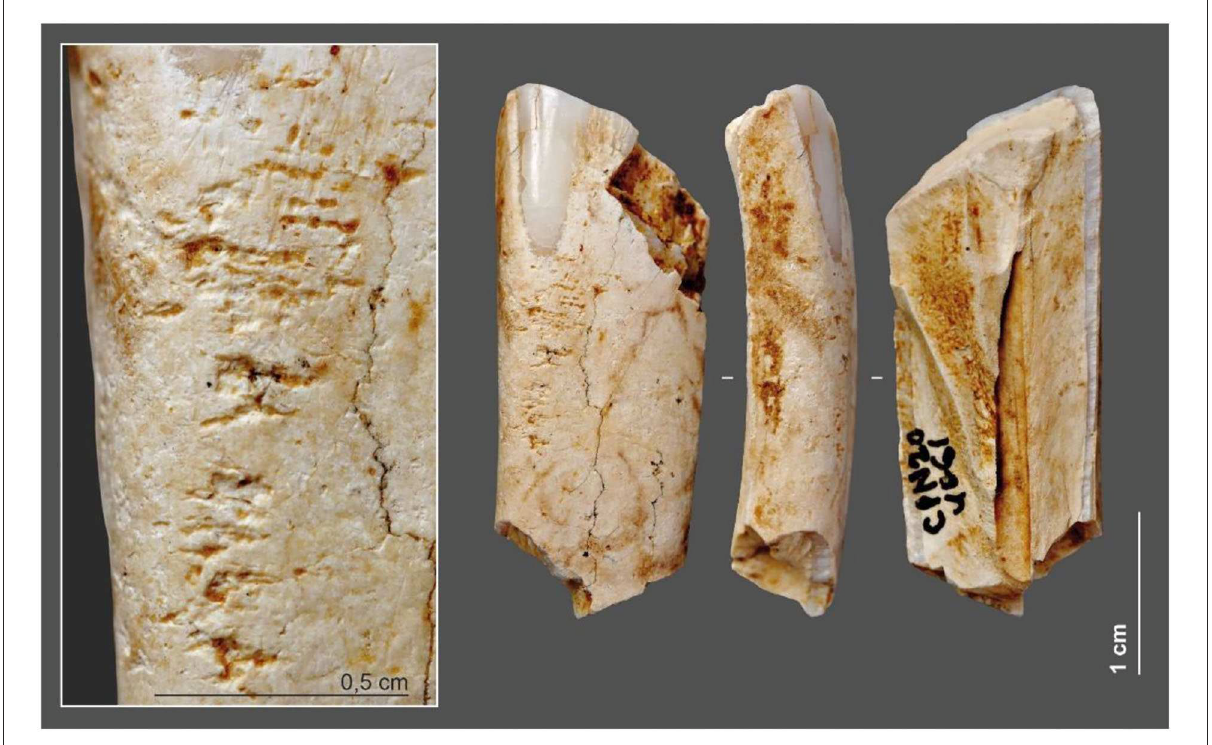
FIGURE8 Piece #4061, decapage 6. Upper horse incisor used as retoucher. Photo and DAO: Malvina